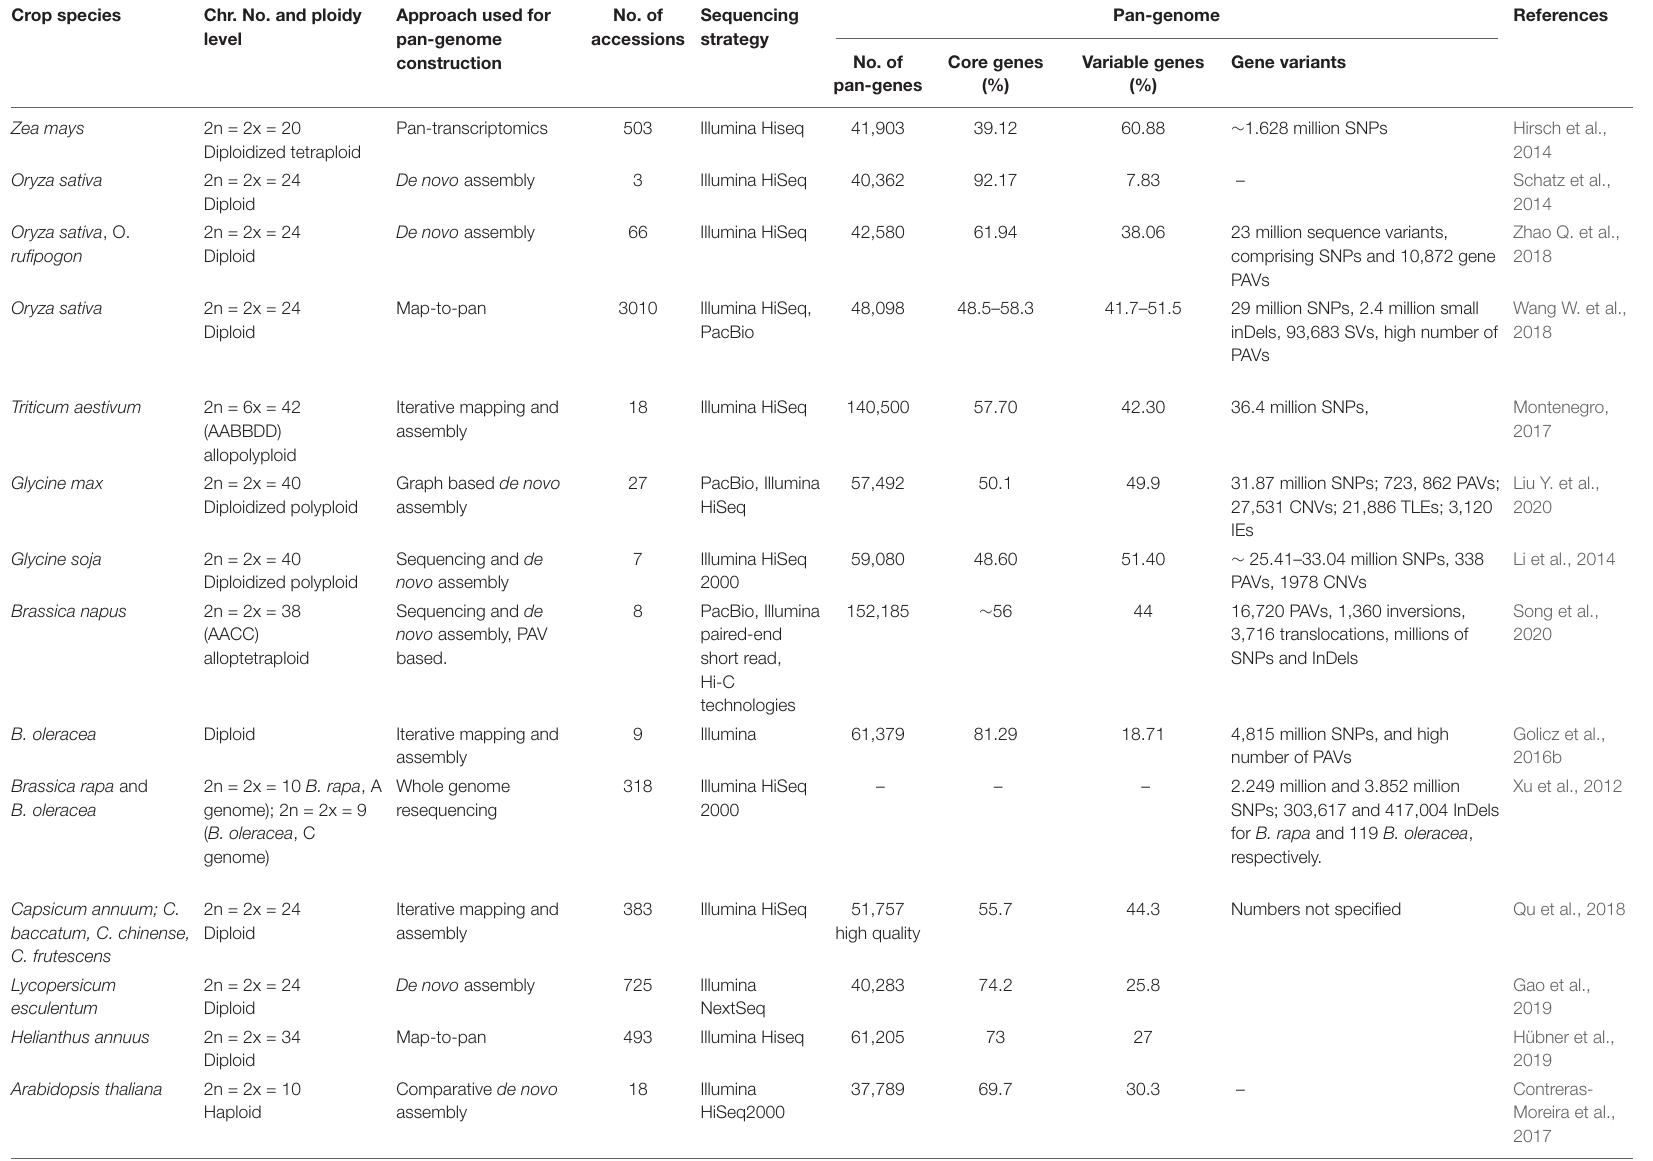
TABLE 2 | Examples of pan-genome studies conducted in major crops and related